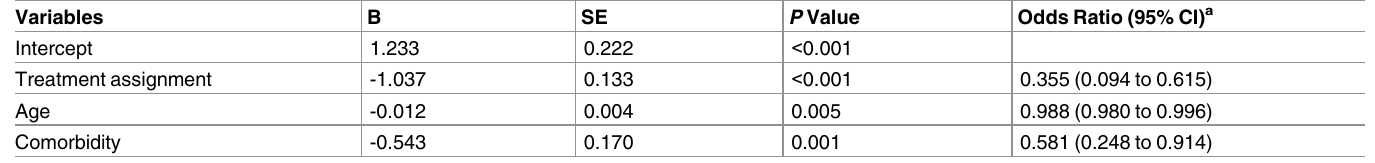
Table 2. Backwardlogistic regression with bootstrap